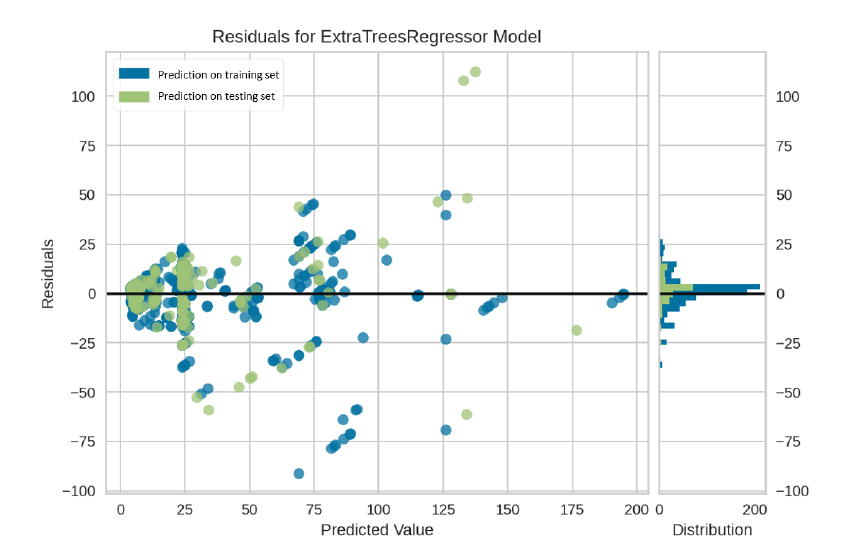
Figure 4. The residuals plot shows the difference between residuals on the vertical axis and the dependent variable on the horizontal axis, allowing us to detect regions within the target that might be susceptible to more or less error. The Histogram on the right side of plot is a common way to check that residuals are normally